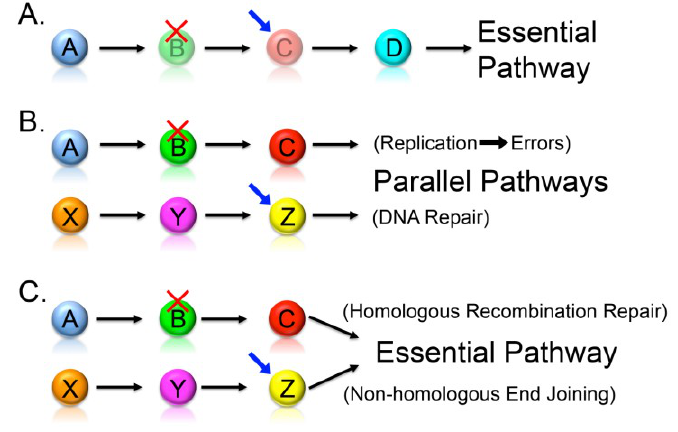
Figure 2. Conceptual Models Depicting the Underlying Mechanisms that Account for Synthetic Lethal Interactions. Conceptual models detailing three mechanisms that produce a synthetic lethal interaction—circles represent genes, cancer-associated mutations, or deletions are identified by a red ―X‖, and synthetic lethal interactors ( i.e. , drug targets) are identified by blue arrows. ( a ) Partial ablation of two functions encoded within a single essential pathway (e.g., epistasis group), such that the pathway is no longer functional. ( b ) Ablation of two functions encoded within two distinct parallel pathways. For example, defects in DNA replication would lead to DNA errors requiring repair, and small molecule inhibitors preventing accurate repair will cause lethality. ( c ) Ablation of two functions encoded within two separate pathways that together impinge on a single essential process. For example, DNA double strand breaks can only be repaired through two pathways, namely homologous recombination repair and non-homologous end joining—defects and inhibition of both pathways will cause cellular